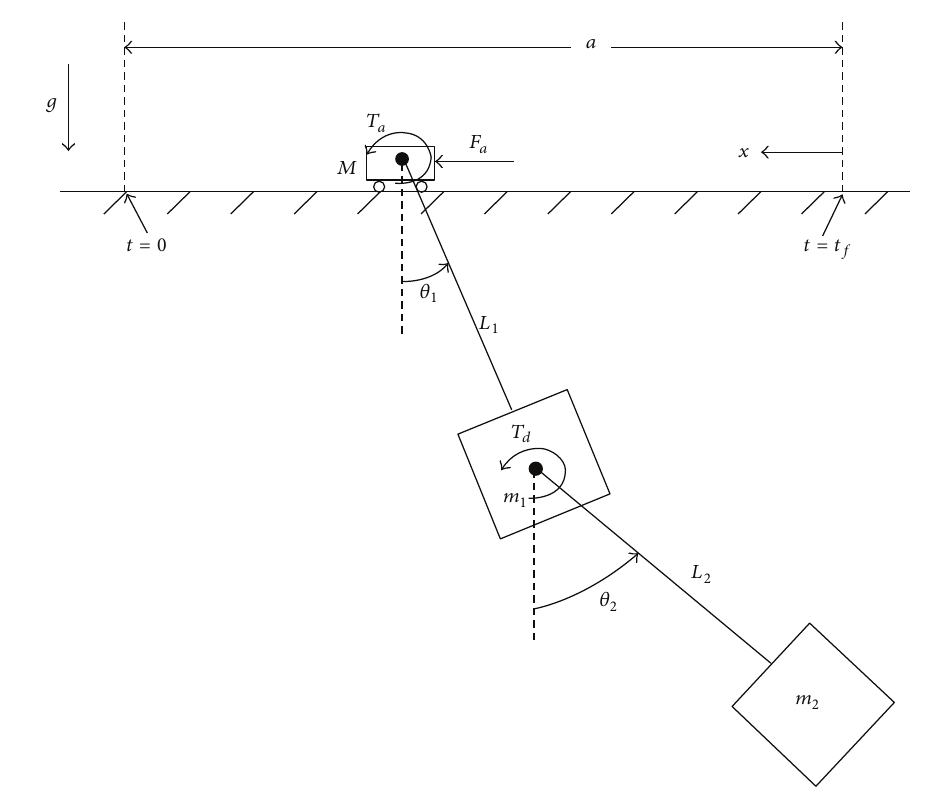
Figure 5: Modified three-DOF gantry crane